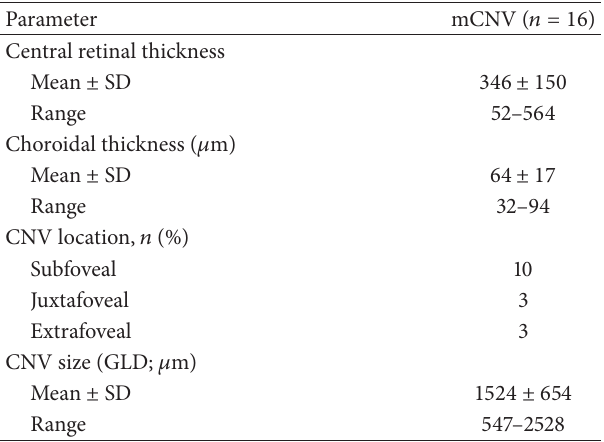
Table 2: Clinical parameter of the eyes with myopic choroidal neo- vascularization.